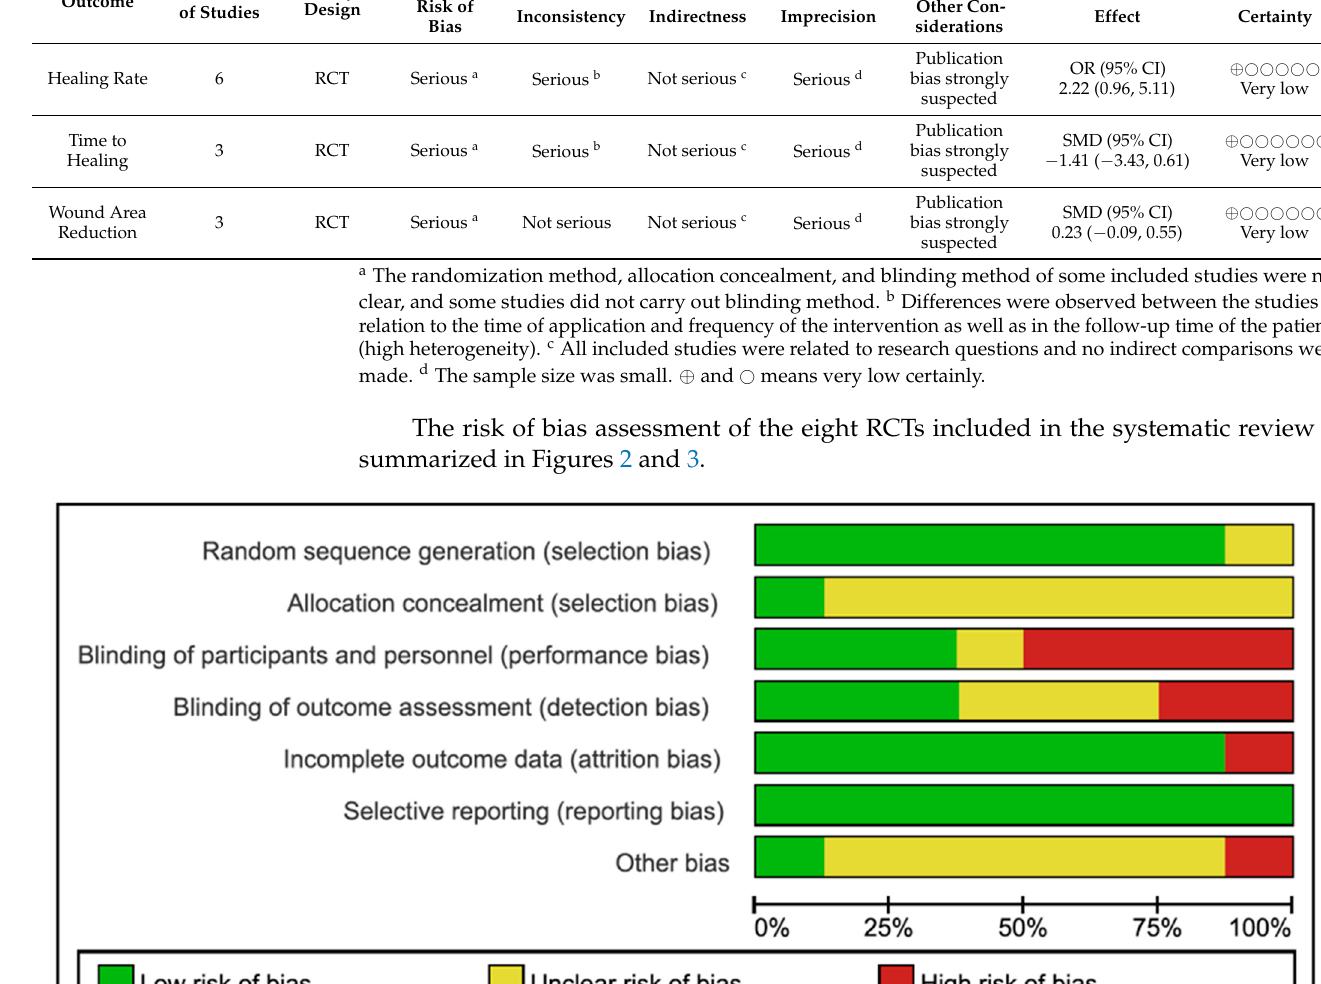
Table 1. GRADE assessment for the effect of UAW on the healing of DFU.